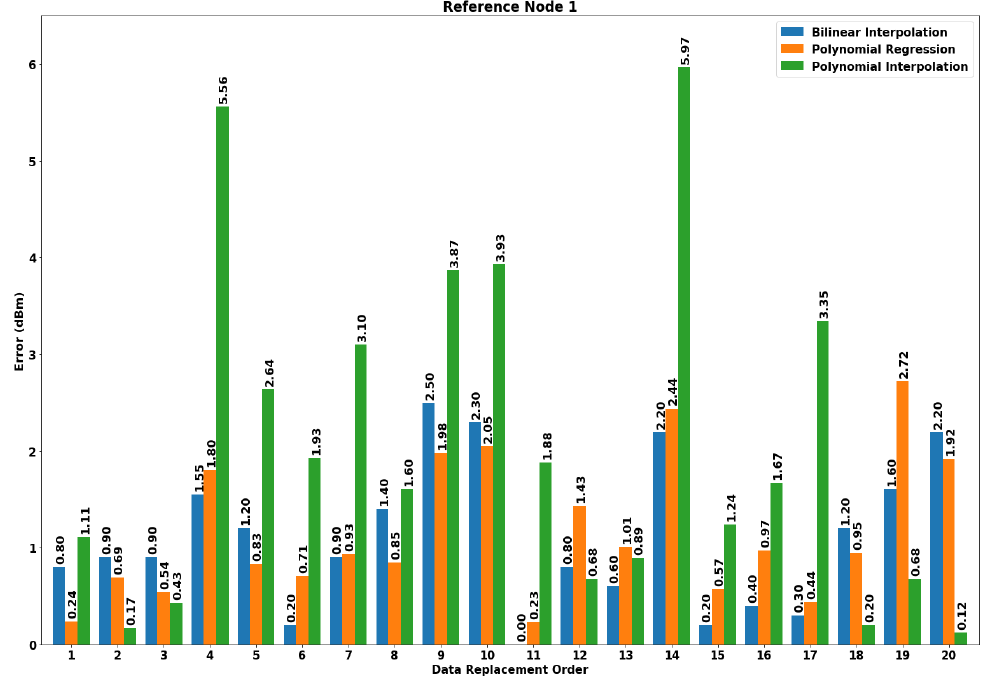
Figure 15. RSSI values error for reference node